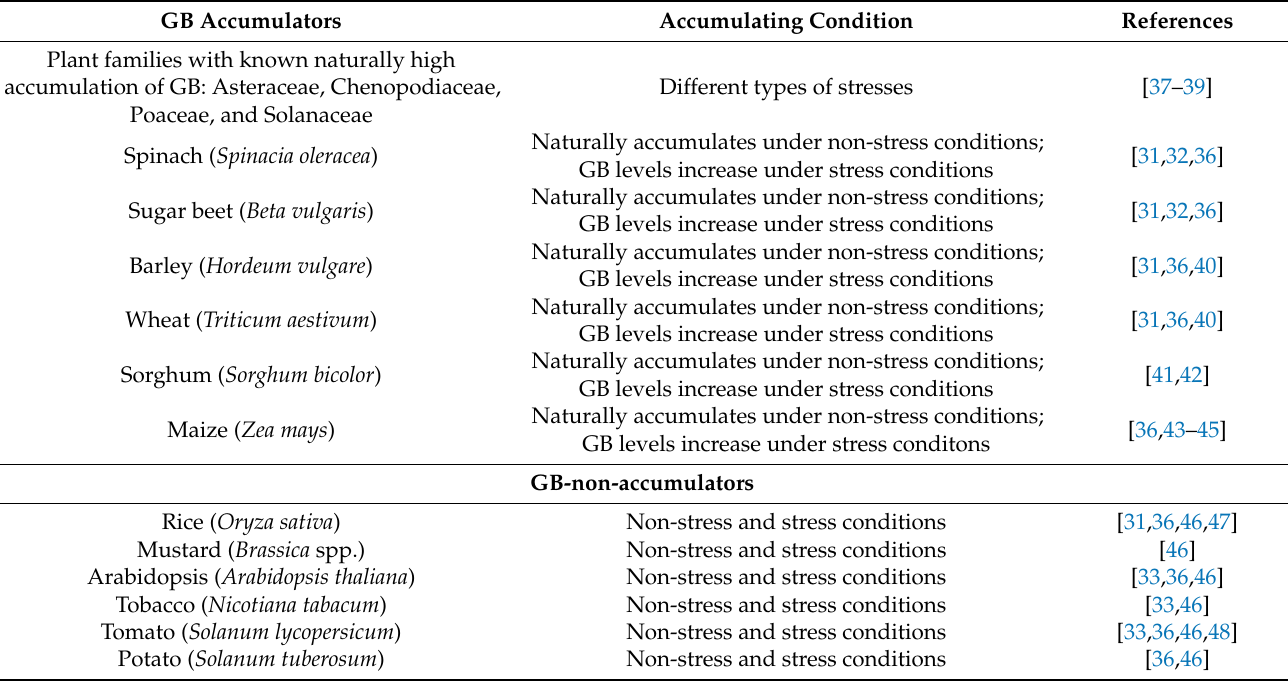
Table 1. Glycine betaine accumulating